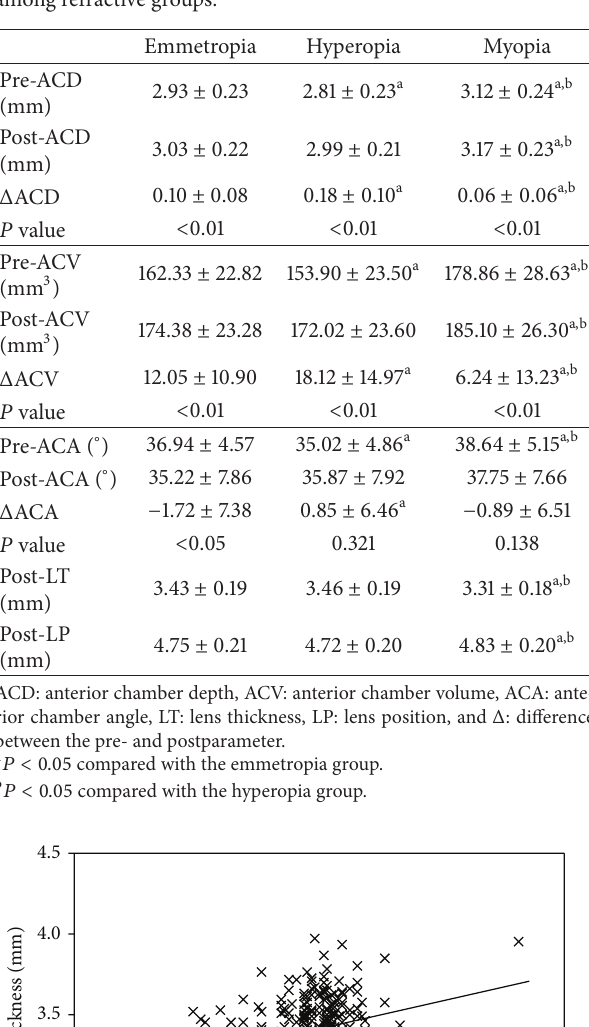
Table 2: Anterior segment parameters before and after cycloplegia among refractive groups.